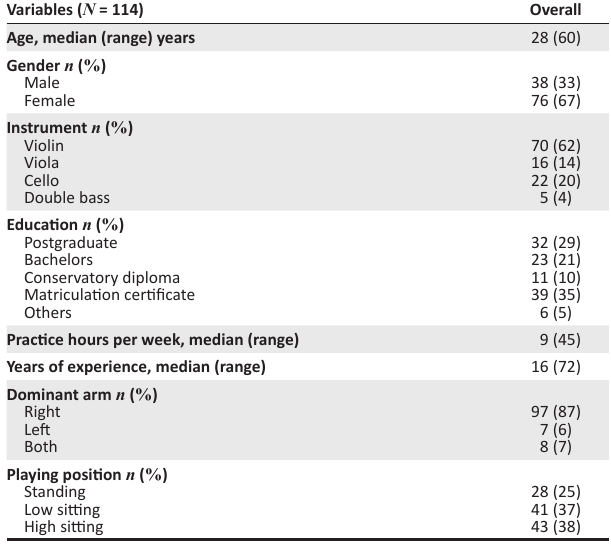
TABLE 2: Demographic information and playing habits of